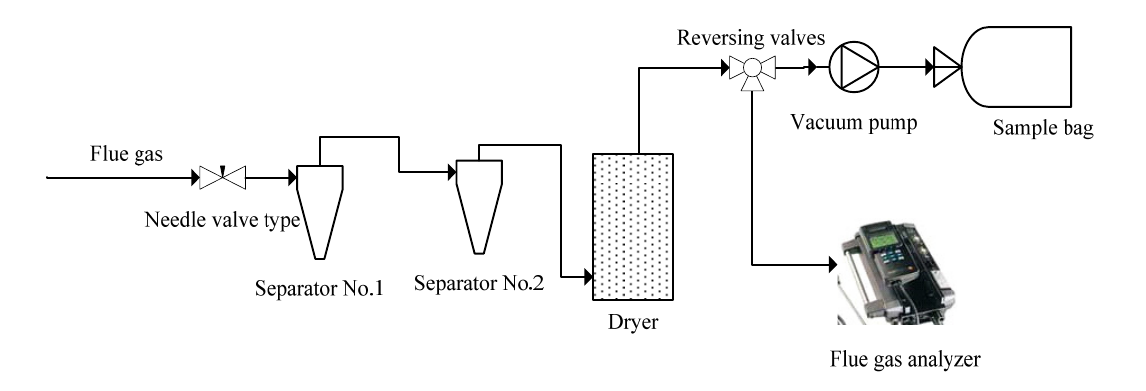
Figure 4. Process diagram of flue gas analysis.